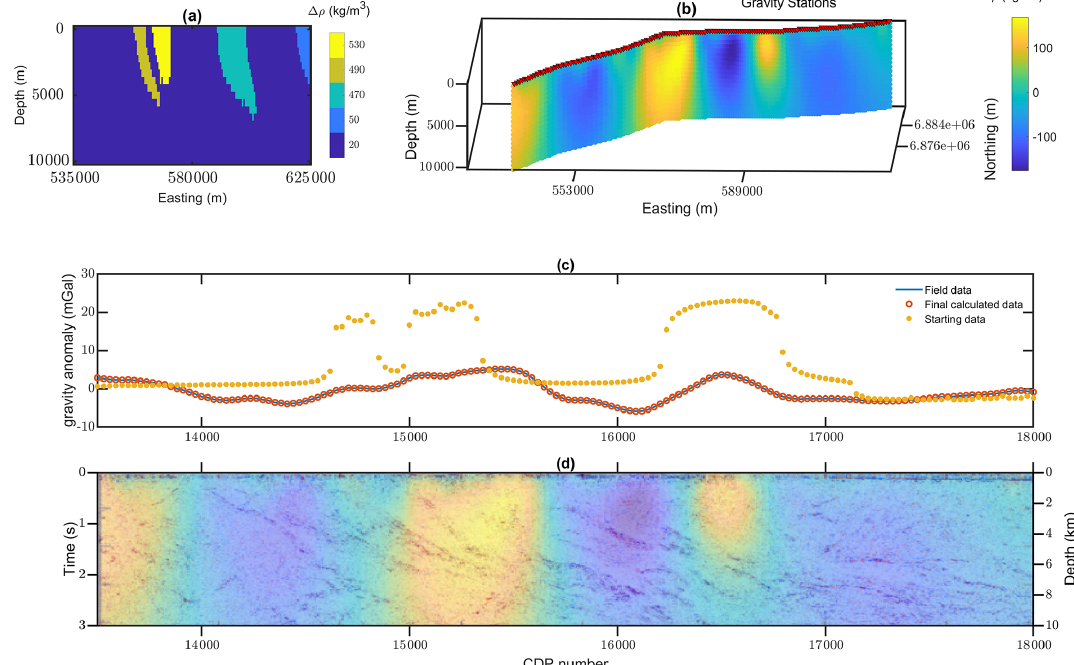
Figure 9. (a) Prior model for the gravity property inversion, (b) gravity density contrast inversion result along seismic profile, (c) comparison of the field data and calculated gravity anomaly from the final inverted model, and (d) the overlaid gravity inversion result on seismic